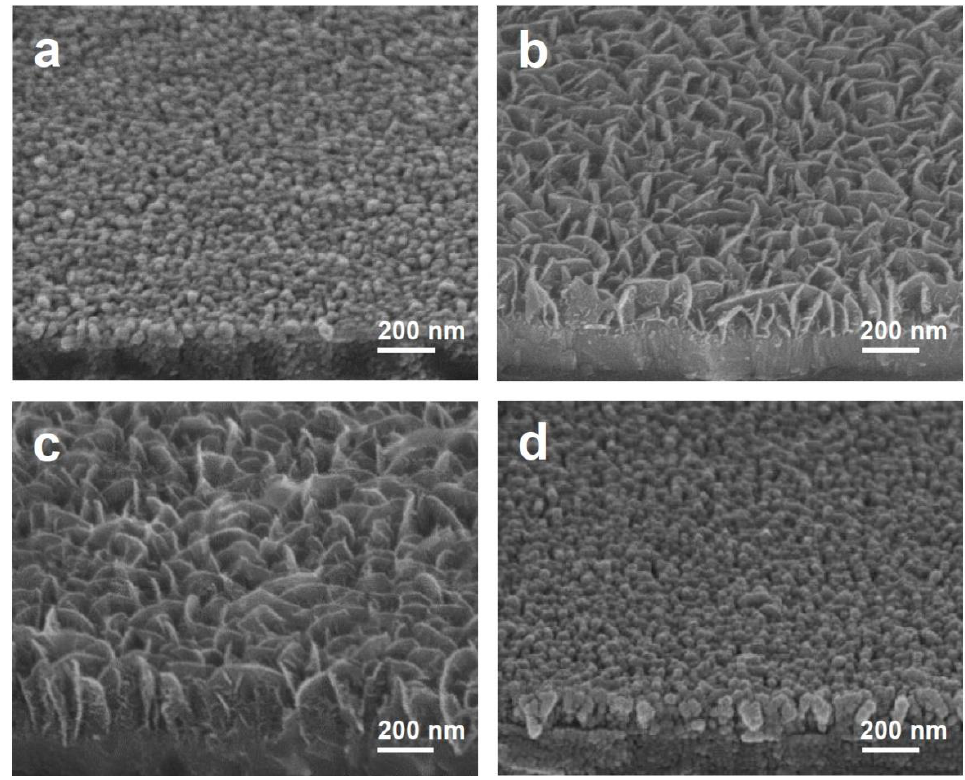
Figure 2. SEM images of MoS 2 nanostructures synthesized on graphene at various growth temper- peratures: ( a ) G/MoS 2 -200 at 200 ◦ C, ( b ) G/MoS 2 -250 at 250 ◦ C, ( c ) G/MoS 2 -300 at 300 ◦ C, and atures: ( a ) G/MoS 2 -200 at 200 °C, ( b ) G/MoS 2 -250 at 250 °C, ( c ) G/MoS 2 -300 at 300 °C, and ( d ) G/MoS 2 - ( d ) G/MoS 2 -350 at 350 ◦ 350 at 350 °C.